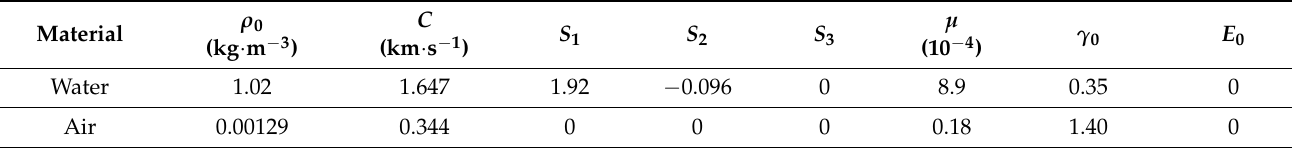
Table 5. Water and air state equation